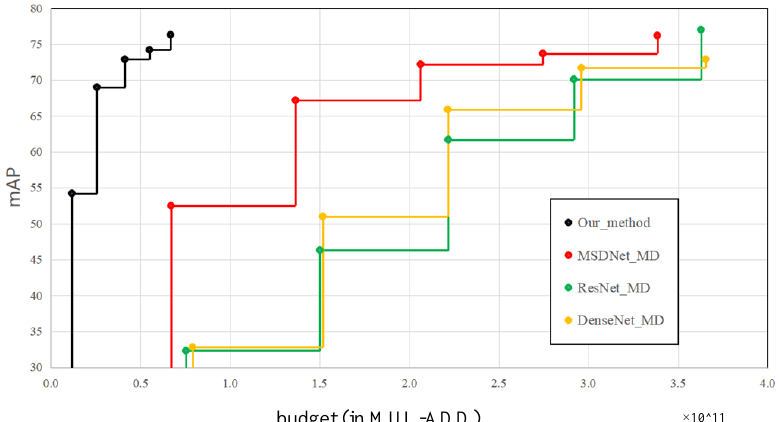
Figure 7. Performance of anytime prediction models as a function of computational budget on the Pascal voc. Higher is better.